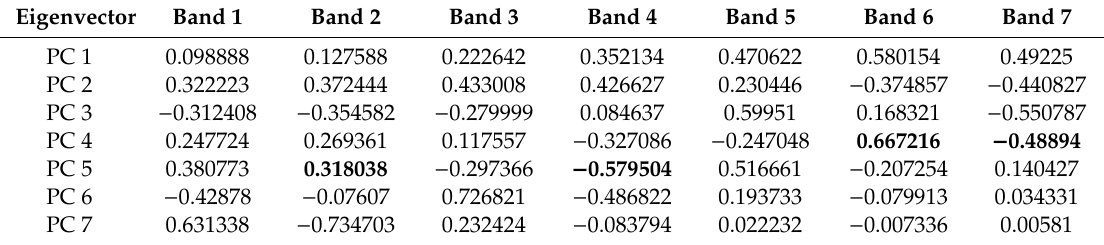
Table 2. Eigenvector matrix derived from PCA for the selected bands of Landsat-8 bands (1 to 7) used in this